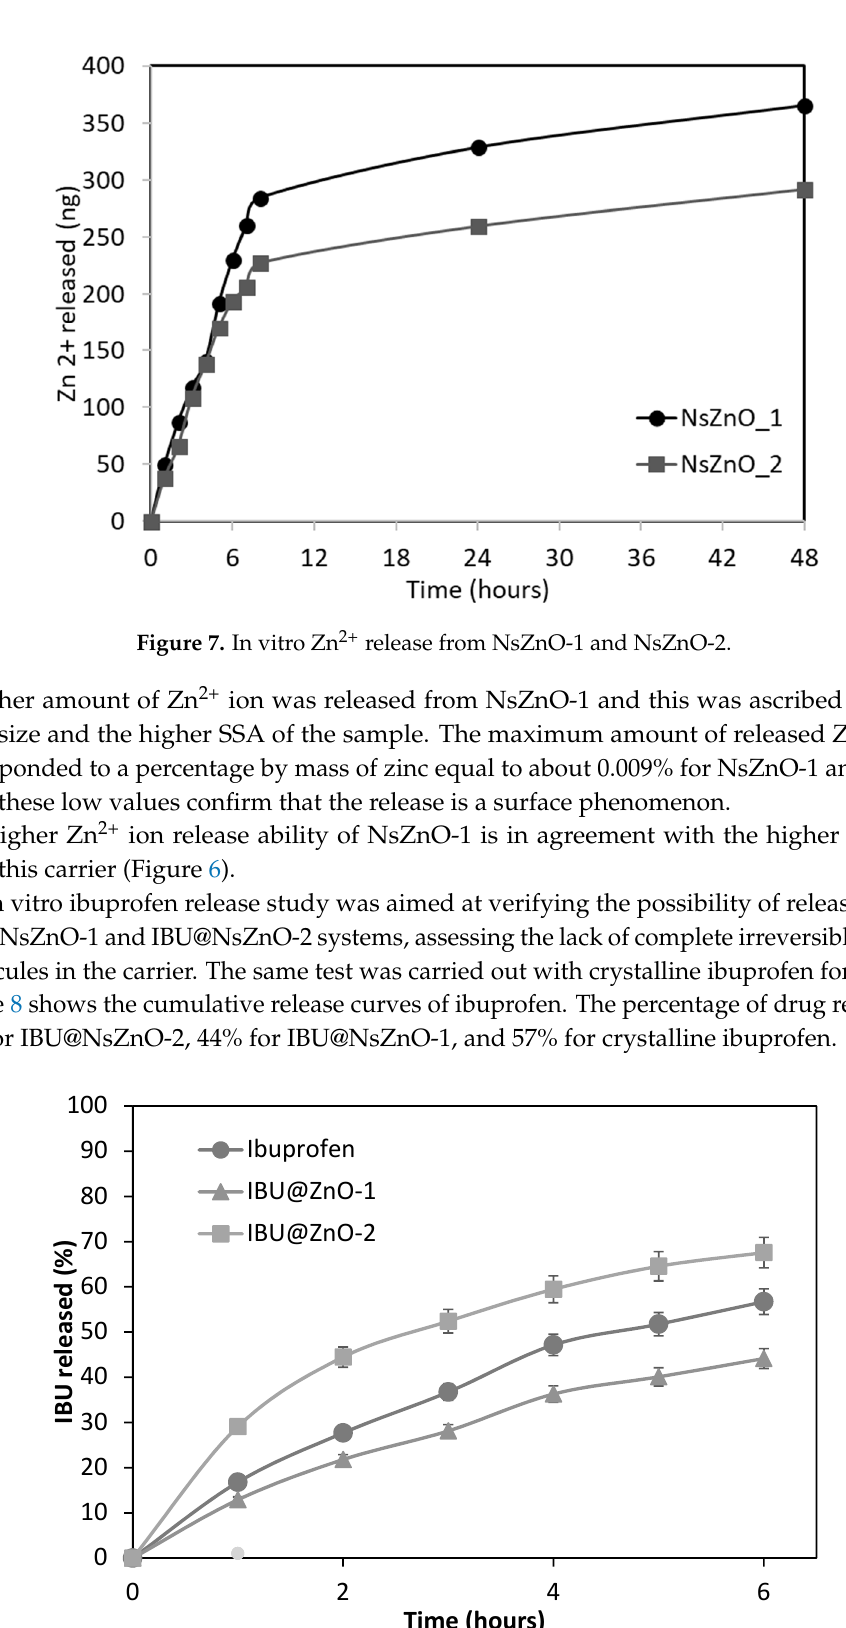
Figure 8. In vitro release profile of ibuprofen from IBU@NsZnO-1, IBU@NsZNO-2, and crystalline ibuprofen.